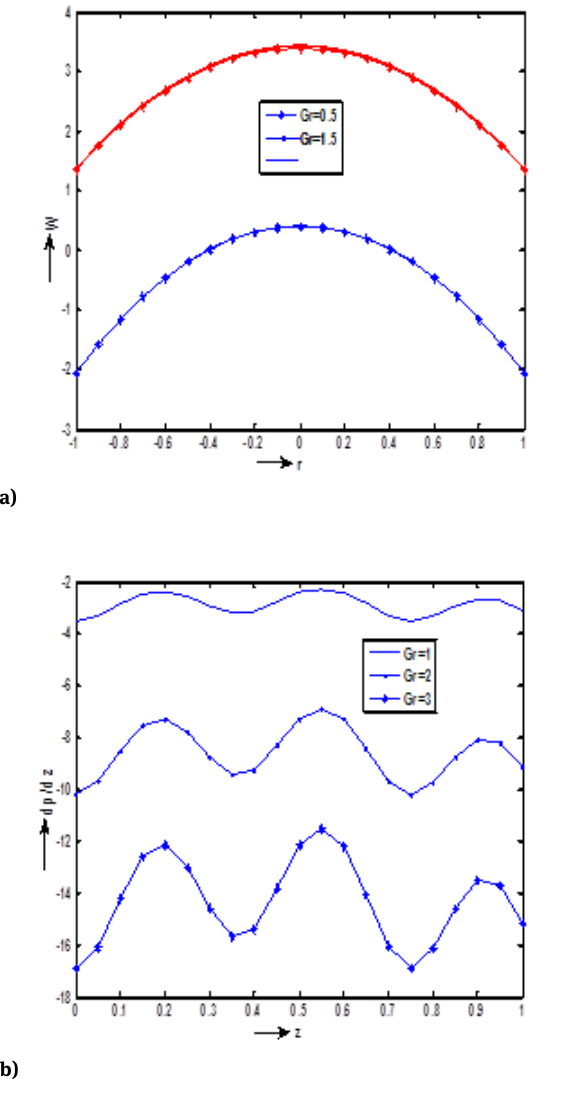
Fig. 5: (a) Velocity profile for various values of M (b) Pressure gradi- ent for various values of M with and without stenosis is shown in Figures 3(a)-3(c). It is clear that the fluid velocity and temperature